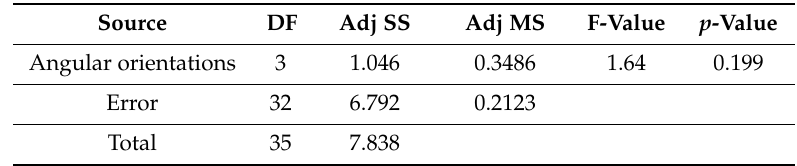
Table 21. ANOVA results for percentage elongation as a function of angular